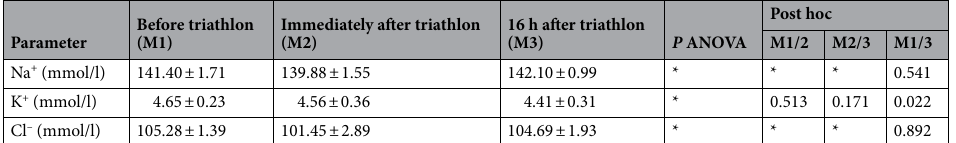
Before triathlon (M1)